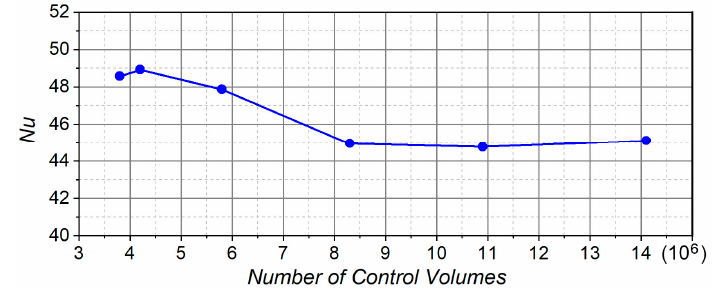
Figure 5. Nu dependence on the number of control volumes.